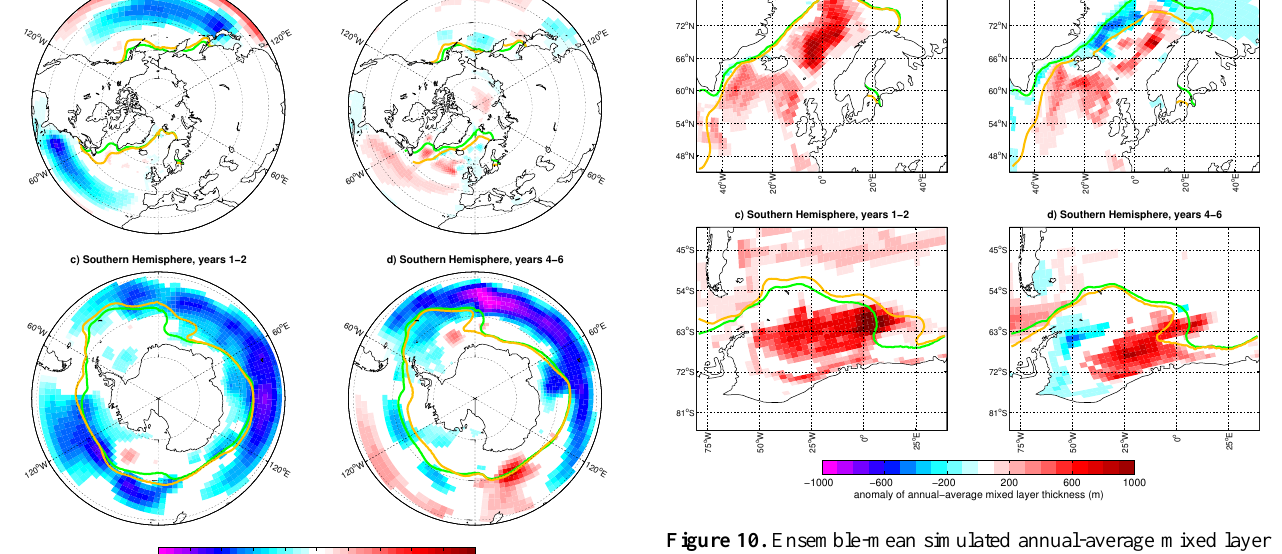
Figure 10. Ensemble-mean simulated annual-average mixed layer thickness in two oceanic deep convection regions for integration years 1–2 (a, b) and 4–6 (c, d) of the SUPER1 ensemble. Only changes statistically significant at 95% confidence are shown. The green and orange lines indicate, respectively, the pre-eruption and post-eruption average winter (top: DJF; bottom: JJA) sea-ice